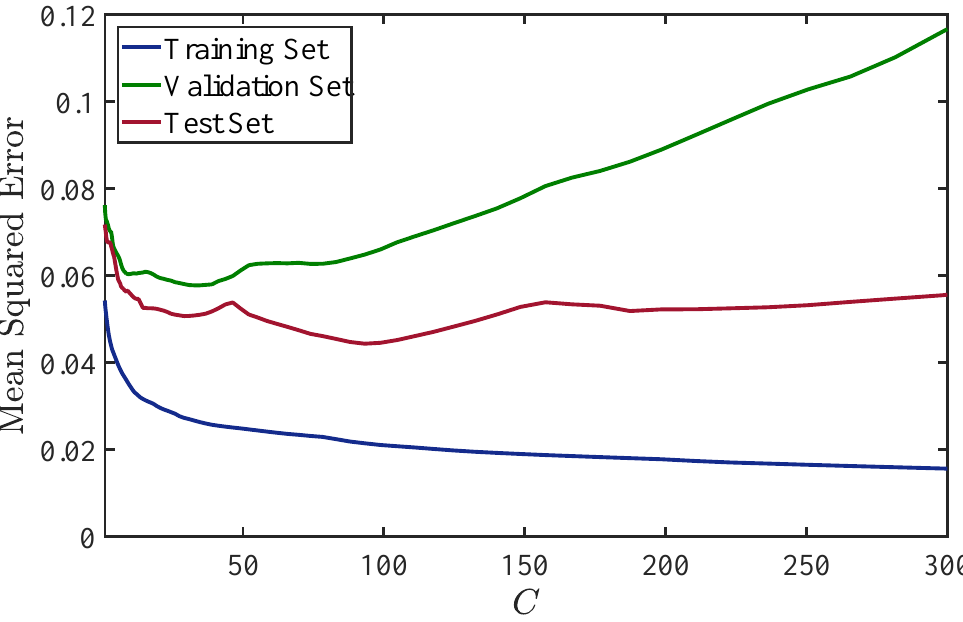
Figure 8. Effect of the hyperparameter C on the loss function for the training, validation, and test